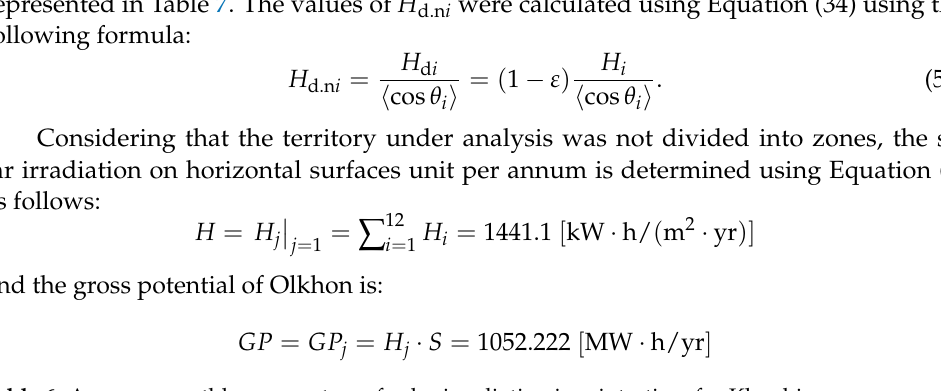
Table 6. Average monthly parameters of solar irradiation in wintertime for Khuzhir.